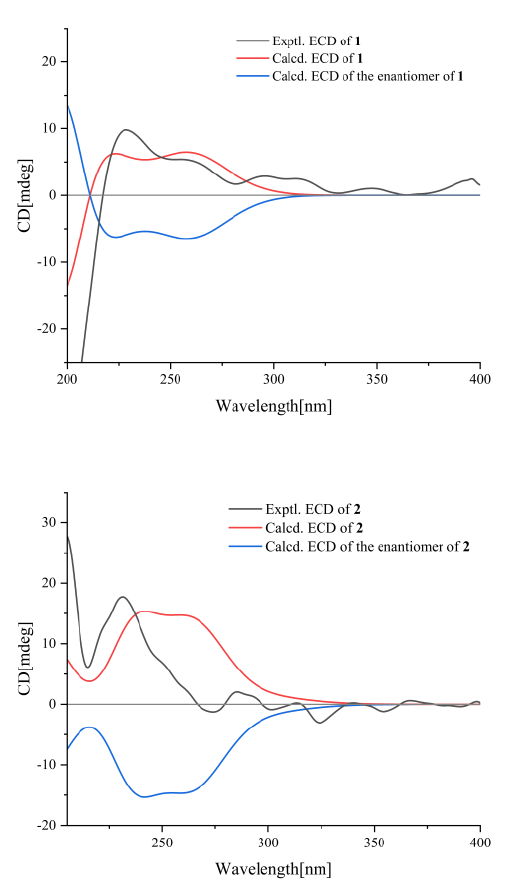
Figure 3. The ECD spectra of compounds 1, 2 . Compound 2 was also obtained as an amorphous powder. The molecular formula was established as C 25 H 30 O 9 (9 degrees of unsaturation) from its HRESIMS ( m / z 497.1785, [M + Na] + ) (calcd for C 25 H 30 O 9 Na, m / z 497.1782). Its IR spectrum showed absorption bands consistent with the presence of hydroxy (3436 cm − 1 ), carbonyl (1738 cm − 1 ), alkenyl (1453 cm − 1 ), and aromatic ring (767 cm − 1 ) functionalities. The 1 H and 13 C NMR signals (Table 1) of 2 were almost identical to those of 1 . The discriminating coupling constants of H-7, H-8 and H 2 -9 indicated the relative stereochemistry of 2 was different from 1 , thus 2 was suggested to be the epimer of 1 at C-7 or C-8 and erythro sterostructure, which was confirmed by the ECD spectra (Figure 3), indicating that 2 gave an exactly opposite Cotton effect at 220 nm compared with that of 1 . The absolute configuration of 2 was proposed as depicted, based on the calculated ECD curve, where the calculated values of 7 R and 8 S matched the experimental ECD curve (Figure 3), allowing the absolute configuration of 2 to be defined as 7 R , 8 S . Hence, the structure of 2 was designated and named jatrolignan D. To determine whether compounds 1 and 2 were natural or artificial products, the MeOH extract of J. curcas was subjected to an MCI gel column with MeOH/H 2 O (80%), applied to Sephadex LH-20 (MeOH), and then compared to the isolated compounds 1 and 2 using HPLC. The HPLC (Supporting information) showed that the preliminary extract contained compounds 1 and 2 , indicating that the both 1 and 2 are a metabolites of the